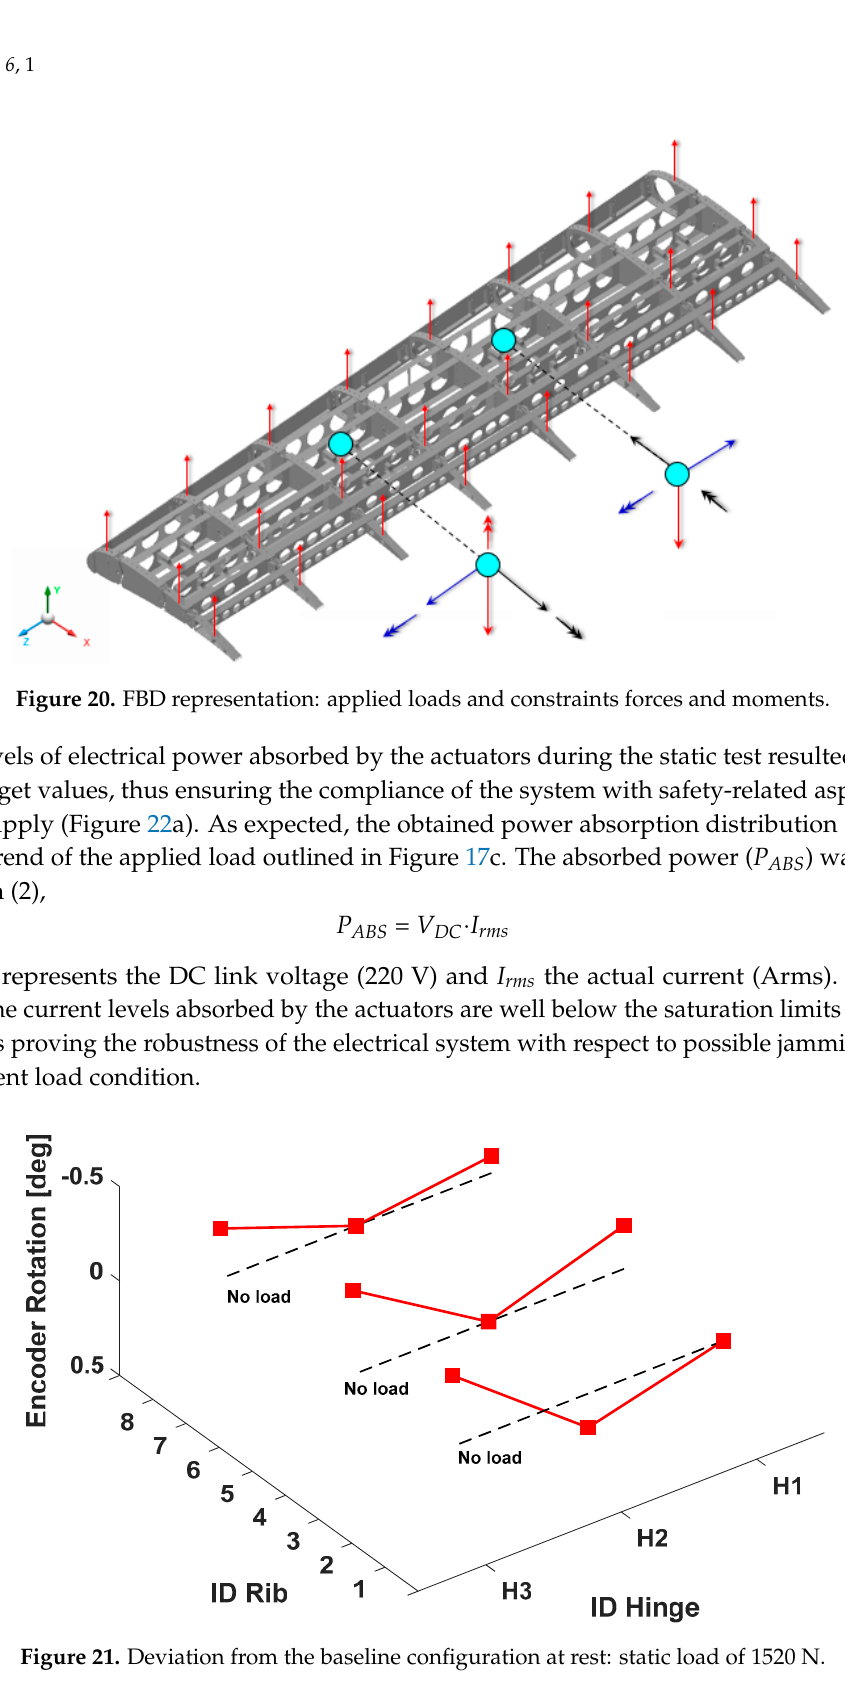
Figure 19. Detail of the load application ( a ) and constraints ( b ) (aft view).